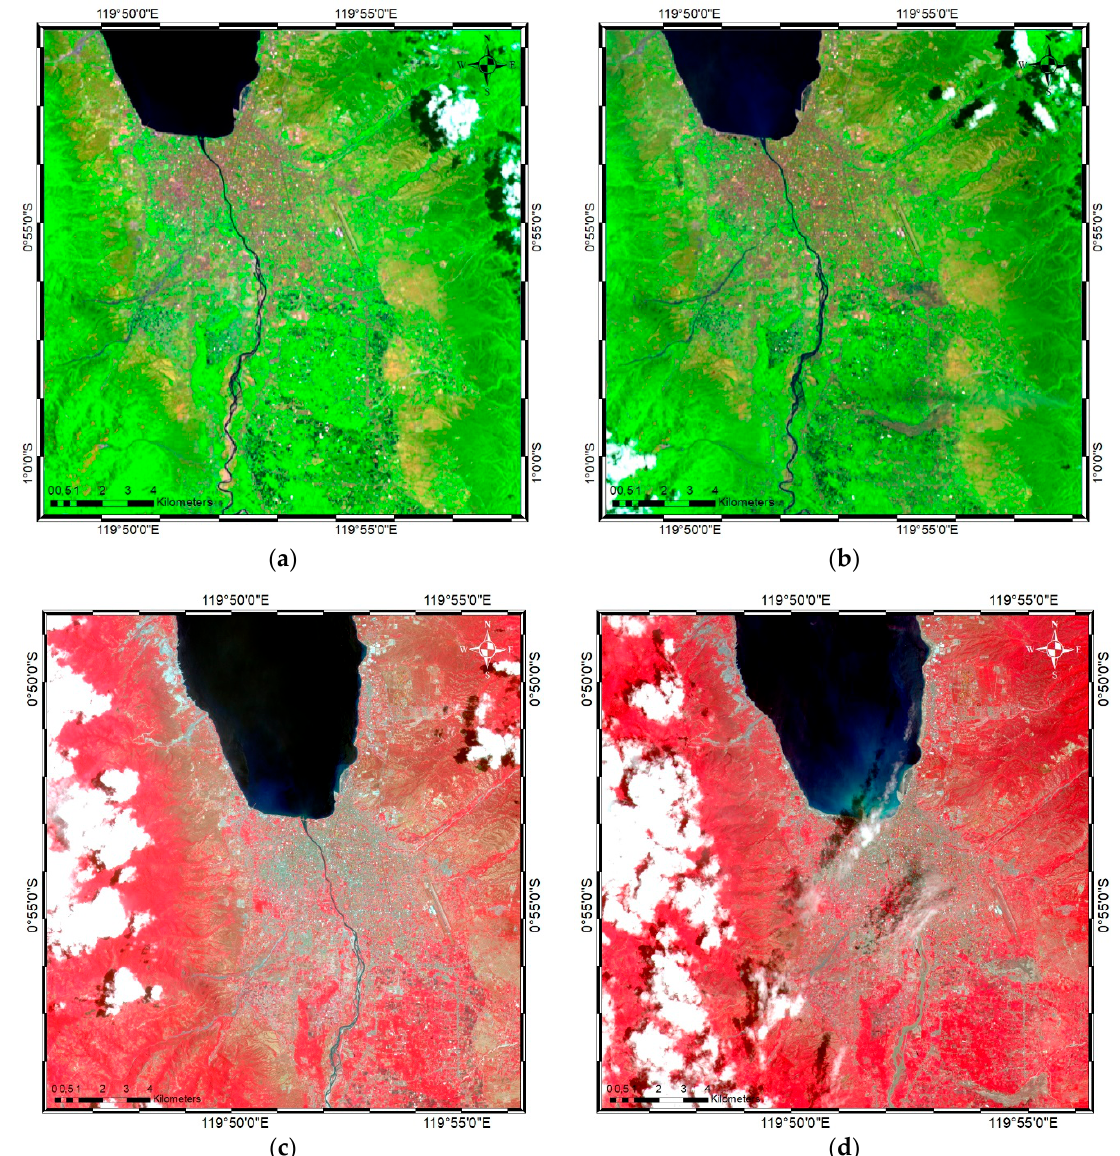
Figure 5. False color combination images of Palu, Indonesia, captured by Landsat-8 ( a ) pre-earthquake on 16 September 2018 and ( b ) post-earthquake on 2 October 2018, and by Sentinel-2 on ( c ) 17 September 2018 and ( d ) 22 October 2018.